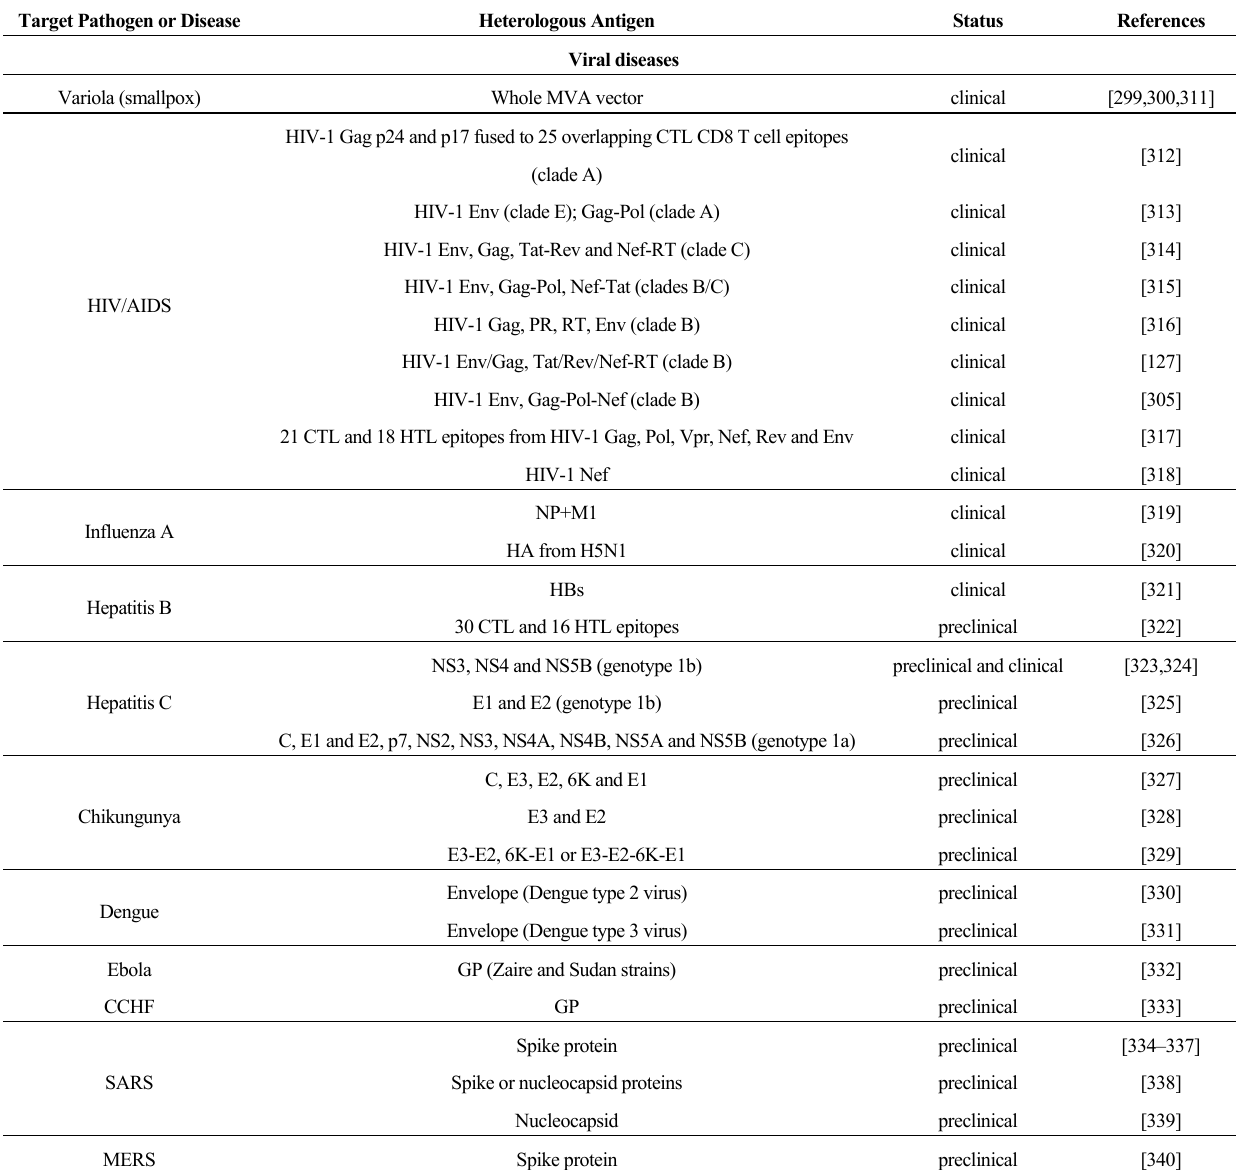
Table 6. Preclinical and clinical trials using MVA vector as a vaccine candidate against different viral, bacterial and parasitic infectious